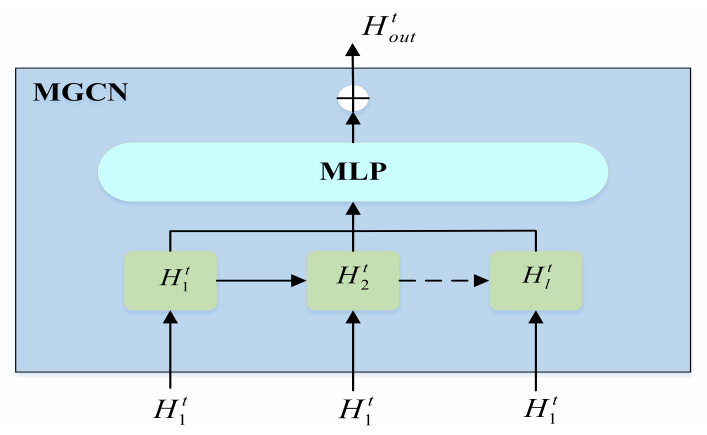
Figure 4. The model structure of